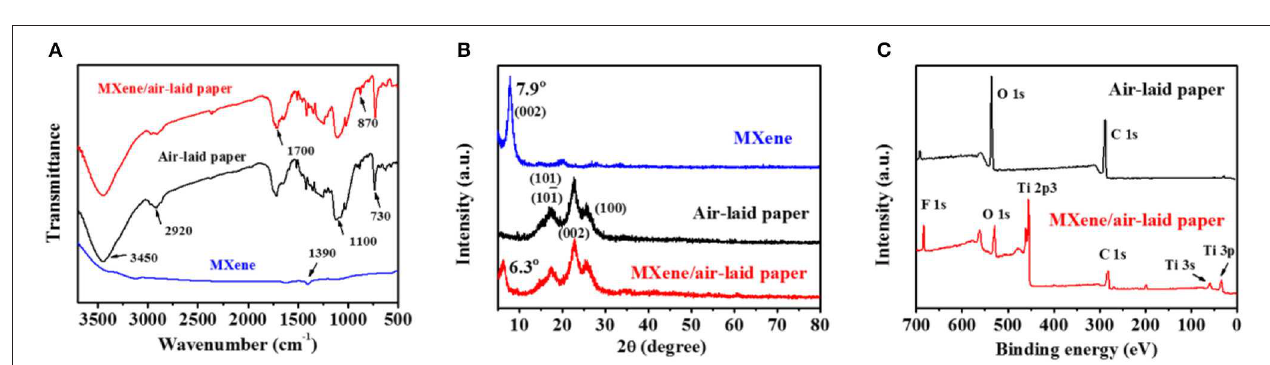
FIGURE 1 | Schematic illustrating (A) the preparation of MXene ink and (B) the fabrication of breathable MXene-decorated air-laid paper in EMI shielding.